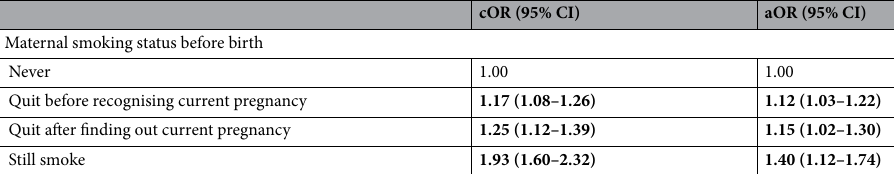
Table 4. Association between prenatal maternal smoking status and risk of bronchial asthma at the age of 3 years in participants without postnatal second-hand smoke exposure. cOR, crude odds ratio; aOR, adjusted odds ratio; CI, confidence interval. Boldface indicates statistical significance ( p < 0.05). Adjusted for partner’s smoking status before birth, frequency of second-hand smoke exposure during pregnancy, maternal history of bronchial asthma, maternal age at birth, pre-pregnancy body mass index, maternal educational level, child’s sex, gestational age at birth, mode of delivery, attendance to childcare facility at 1 year of age, breastfeeding at 1 year of age, and older